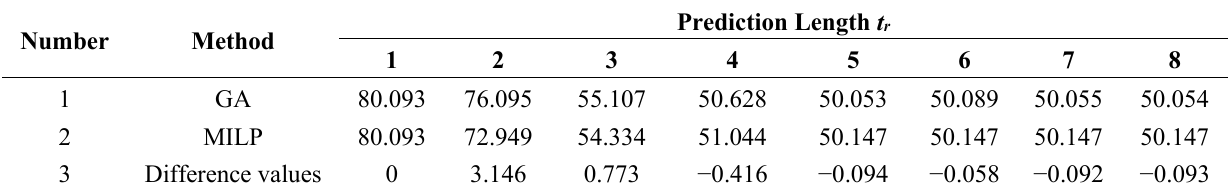
Table 6. The RHC of predictive optimal results for different